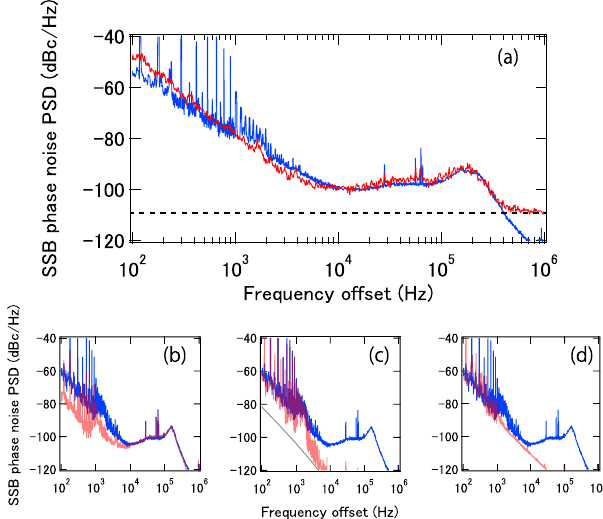
Fig. 5 Phase noise limit. a Single-sideband (SSB) phase noise power spectral densities (PSDs) of the microwave down-converted from the two THz waves (red curve) and the sum of the out-of-loop phase noise PSDs of f f rep1 and rep2 (blue curve). The dashed line shows the measurement noise fl oor for the microwave limited by the generated THz power. b In-loop phase noise PSD of the stabilized f rep of comb 1 (red curve). c Fiber noise limit (red curve) and theoretical thermal noise of the fi ber 39 – 41 (gray line). d Optical signal-to-noise ratio (OSNR) limit of the TWDI (red curve). The blue curves in b – d are the out-of-loop phase noise PSD of the stabilized f rep of comb Here, the in-loop phase noise PSD of the stabilized f rep is de fi ned as the phase noise PSD of the error signal divided by Δ 2 ∣ H ( if ) ∣ 2 of the TWDI, which is used for the stabilization. For the measurement of the out-of-loop phase noise PSD of f rep , another TWDI is used, and out-of-loop phase noise PSD of the stabilized f rep is de fi ned as the phase noise PSD of the error signal divided by Δ 2 ∣ H ( if ) ∣ 2 of the other TWDI. Although L mw ( f ) overlaps with